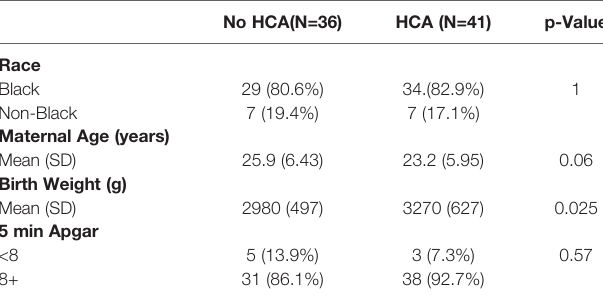
TABLE 2 | Demographic table of study